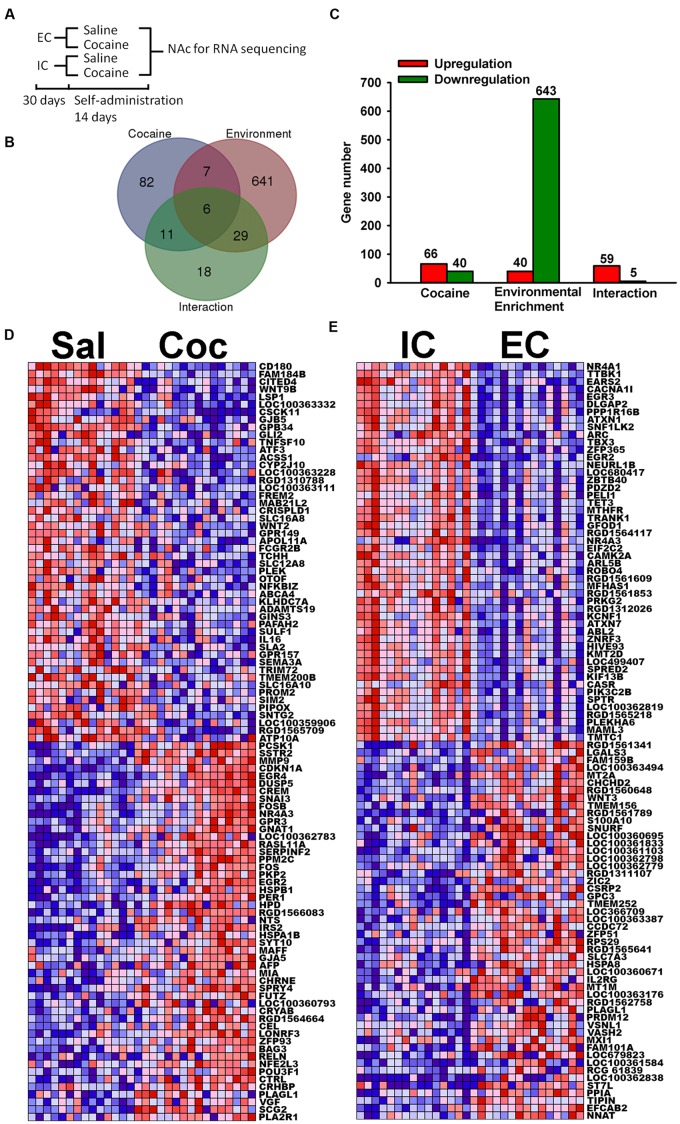
Most highly regulated transcripts.
(A) Schematic diagram of RNA sequencing experiment. (B) Venn diagram of transcripts that are significantly regulated at the p < 0.001 level by Cocaine, Environmental Enrichment, and their interaction. (C) Bar chart showing the number of transcripts that are up or down regulated. (D) Heat maps of top 50 upregulated and downregulated transcripts by cocaine. Red represents high expression and blue represents low expression. (E) Heat map of top 50 upregulated and downregulated transcripts by environmental enrichment. IC stands for isolated condition. EC stands for enriched condition.